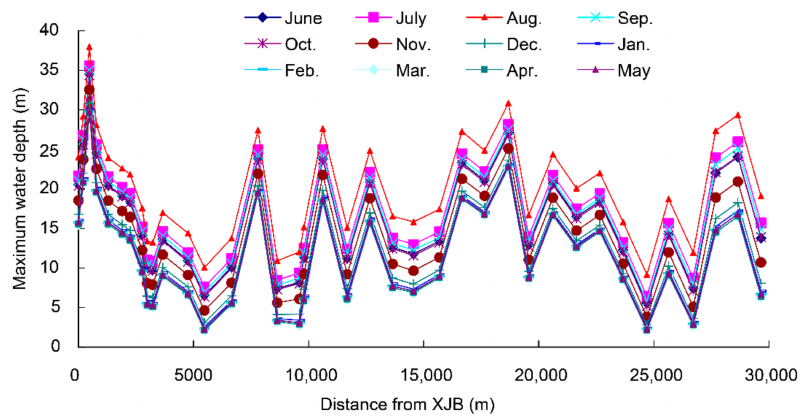
Figure 7. Maximum water depth for each month during typical dry years in the study